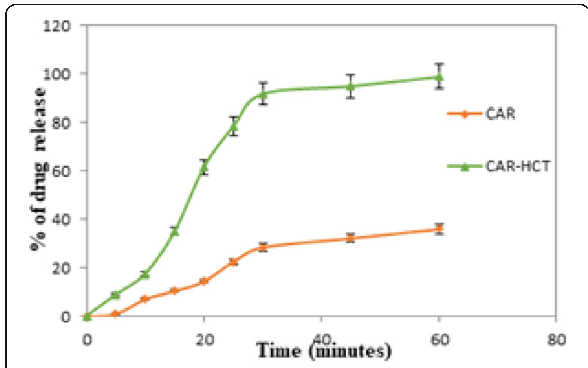
Fig. 12 In vitro drug release comparison of CAR and CAR-HCT ( n = 3) Fig. 13 Single crystal of CAR-HCT